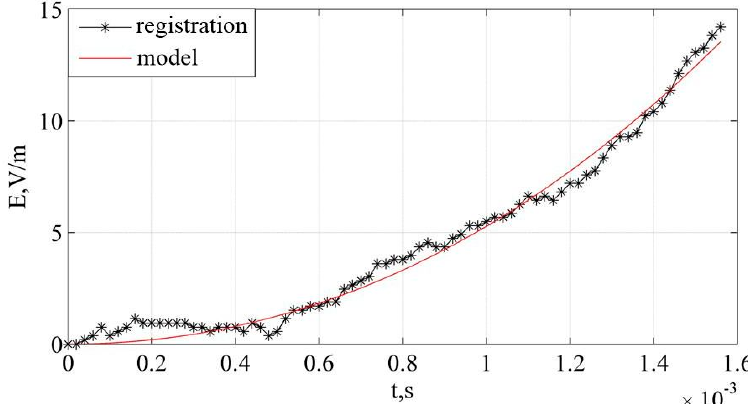
Figure 12. Description is the same as in Figure 10, except the middle distance positive lightning leader E-field change, which is related to Case #5 from Table 1 (see Figure 5).